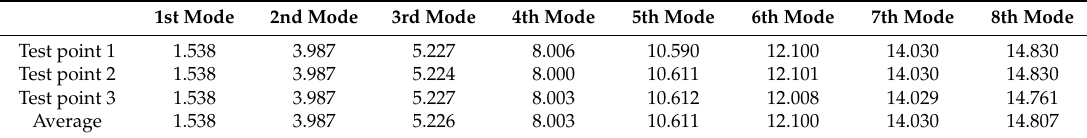
Table 1. Modal frequency in the X direction of the test points under normal conditions.